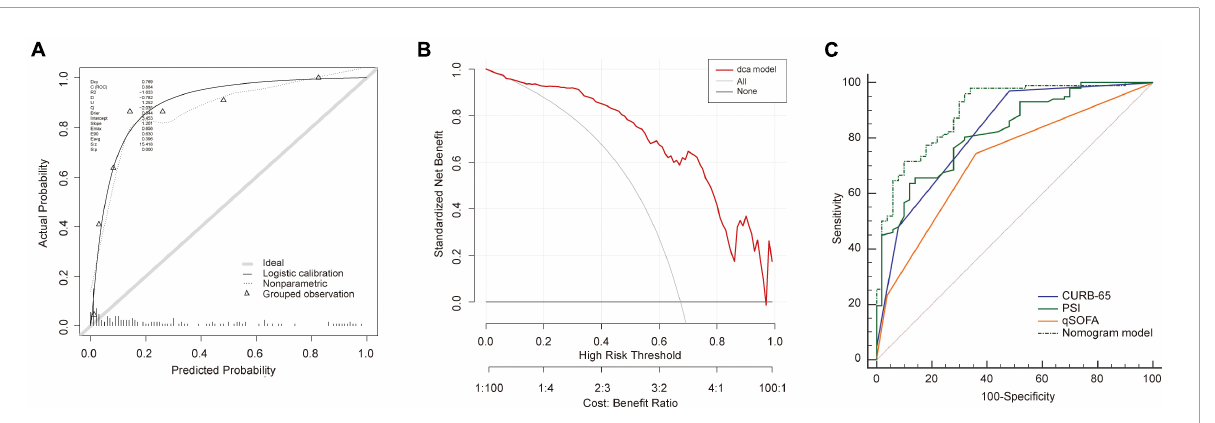
FIGURE6 Validation of the nomogram in external validation cohort. (A) Calibration curves for predicting the mortality in the external validation set. (B) Decision curve analysis for the nomogram model in the external validation set. (C) The receiver operator characteristic curves (ROC) of the nomogram model, PSI, CURB-65 and qSOFA in external validation cohort for predicting the risk of mortality in the elderly with CAP. CURB-65: confusion, urea, respiratory rate, blood pressure, and age ≥ 65 years; qSOFA, quick Sequential Organ Failure Assessment; PSI, Pneumonia Severity Index.